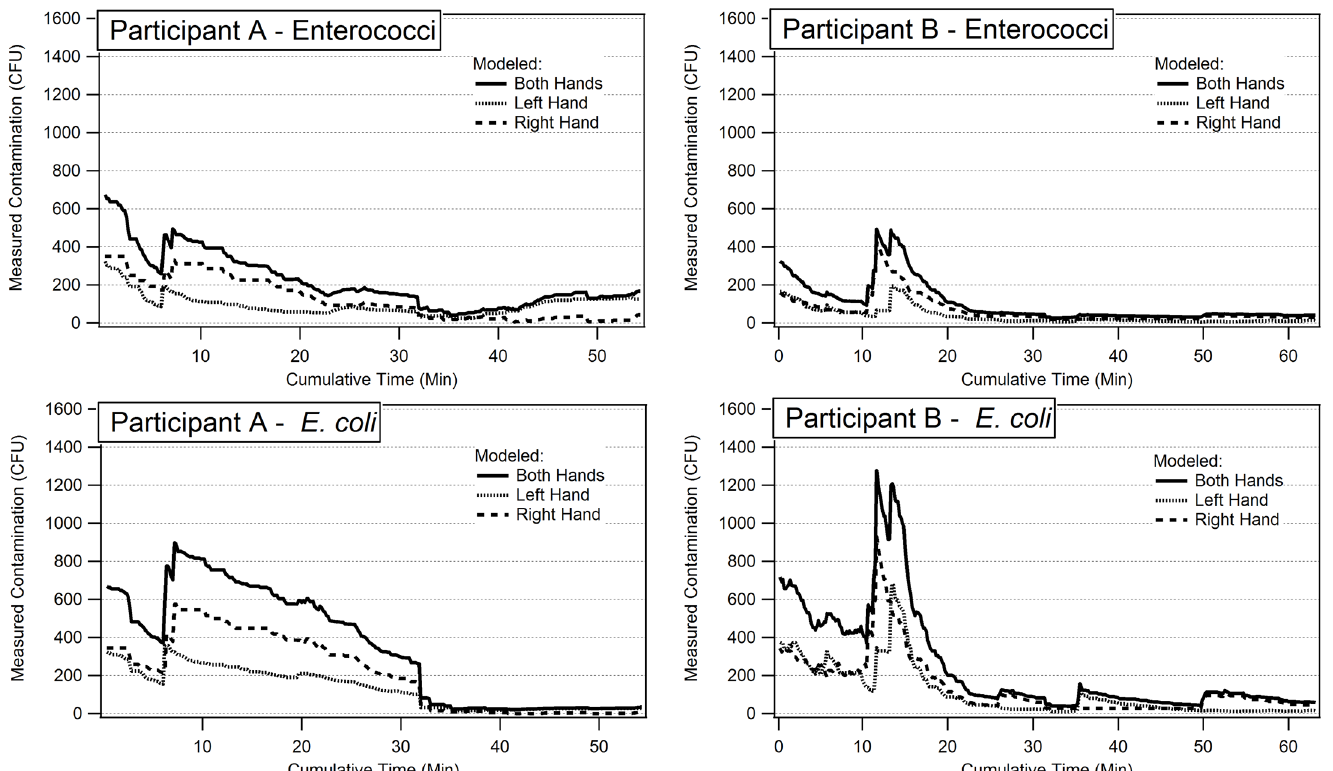
Fig 2. Modeled E . coli and enterococci concentrations on hands of participants, adjusted for sampling